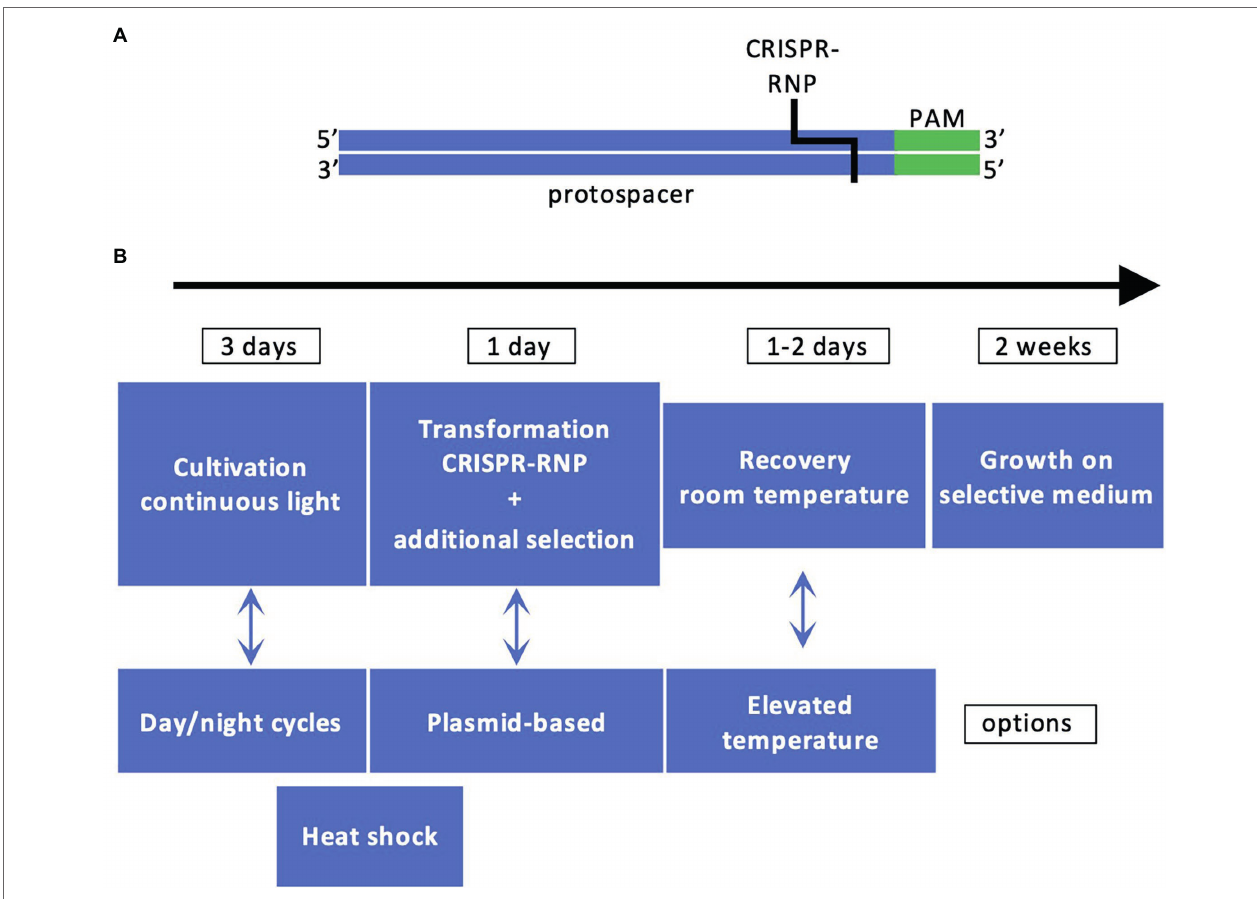
FIGURE 2 | Principles of CRISPR/Cas9 technology in Chlamydomonas. (A) The DNA recognition sequence comprising the protospacer (in blue) and PAM (in green) is recognized by CRISPR-RNP. (B) Workflow for generating CRISPR/Cas9 mutants. The most employed workflow comprises cultivation of cells under light, cotransformation by electroporation with CRISPR-RNP and a resistance cassette with homologous arms or ssODN for targeted insertion, cell recovery, selection based on antibiotic resistance and/or phenotype, and molecular characterization by